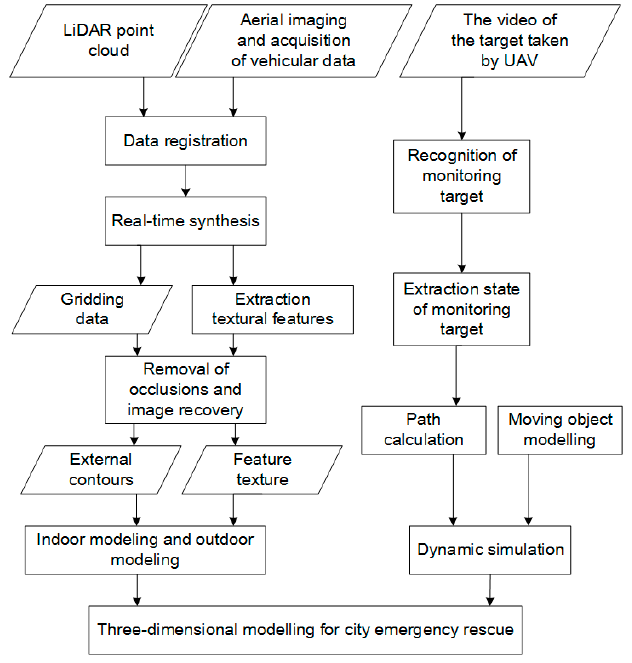
Figure 1. Urban remote-sensing data-acquisition system.